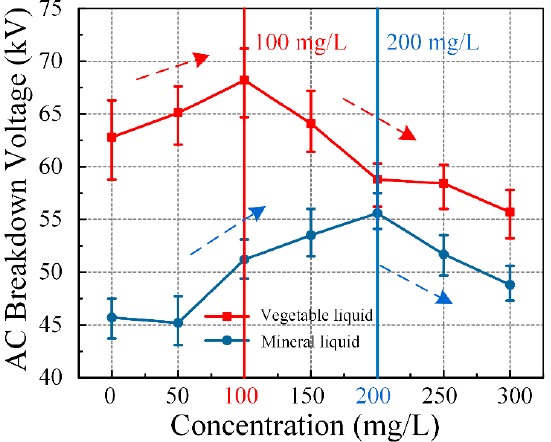
Figure 4. The variation of AC breakdown voltage with C 60 concentrations of vegetable insulating liquid and mineral liquid.